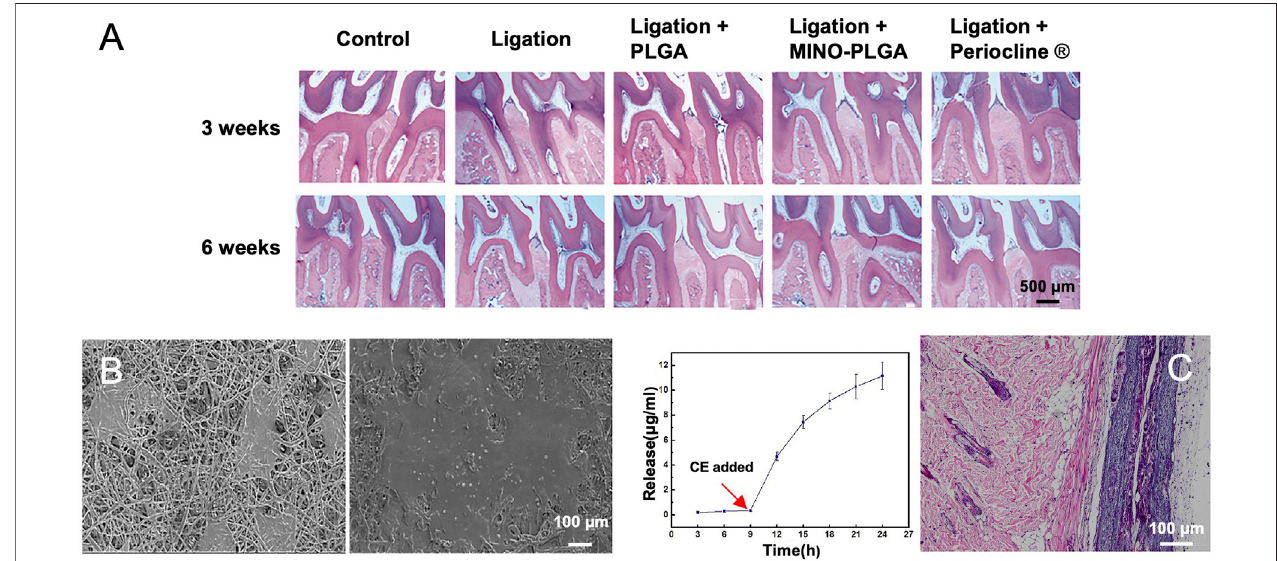
FIGURE7|(A) Histologicalobservation(H&Estain)ofmaxillaryperiodontaltissuesat3and6 weeksposttreatment.Reproducedwithpermission(Maetal.,2020). Copyright 2020, Creative Commons Attribution License. (B) SEM images showing the morphology of MC3T3-E1 cells after culture on the surfaces of multilayered nano fi bers scaffolds containing β -tcp and SIM for 1 and 3 days, respectively. Reproduced with permission (Rezk et al., 2018). Copyright 2018, Elsevier. (C) Pro-MNA releasepro fi leduringaperiodof24 hwiththeadditionofcholesterolesteraseattheninthhour (left) .HistologicalmicrographshowingH&Estainingat8 weekspost implantation of the Pro-MNA-loaded scaffold (right) . Reproduced with permission (He et al., 2020). Copyright 2020, Elsevier.